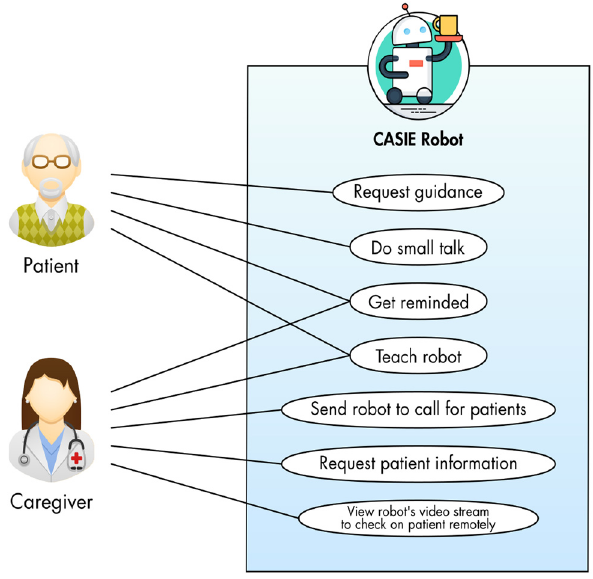
Figure 1: Exemplary list of role - speci fi c use cases from a list of potential